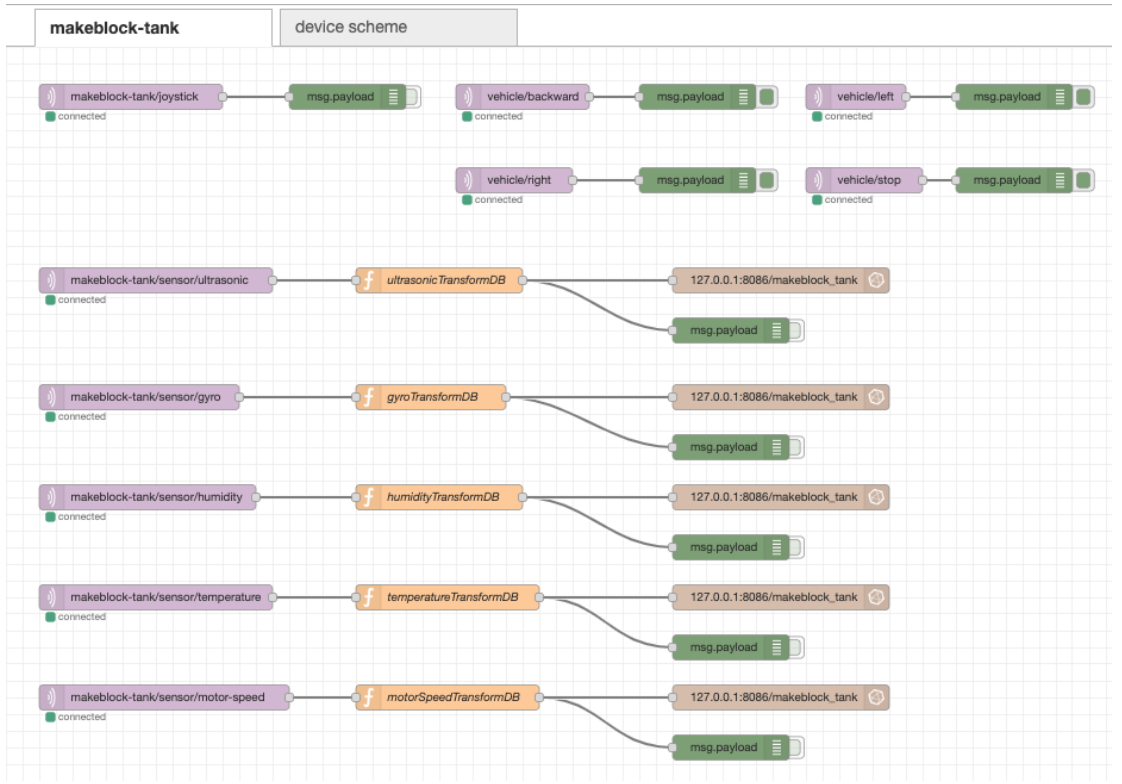
Figure 7. Node-RED flow for mechatronic device Makeblock